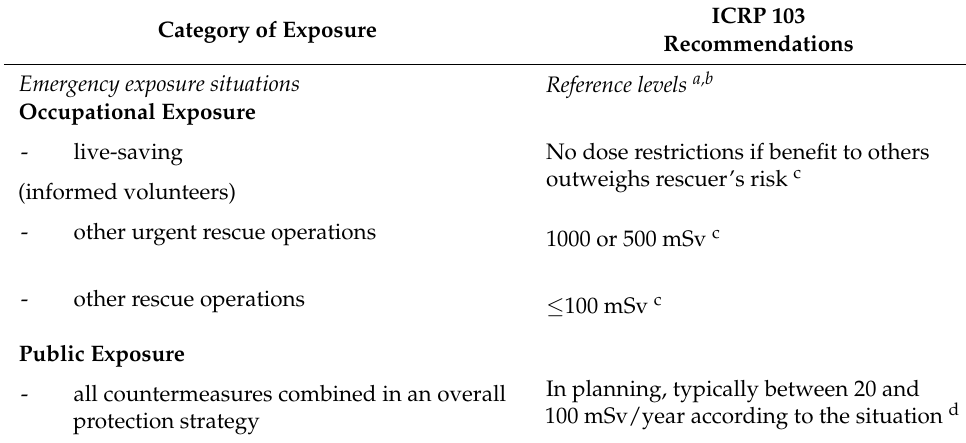
Table 1. Protection criteria in emergency exposure situations, from ICRP 103 [5]—see Appendix A for a,b,c,d’s